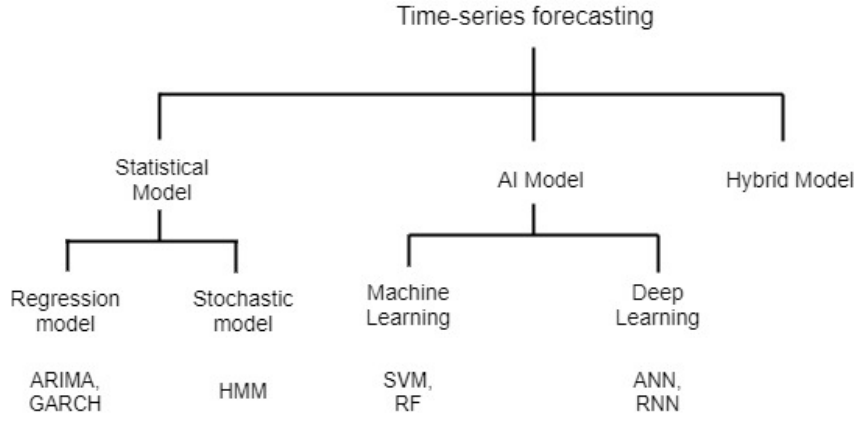
Figure 1. Classification tree of price forecasting models.